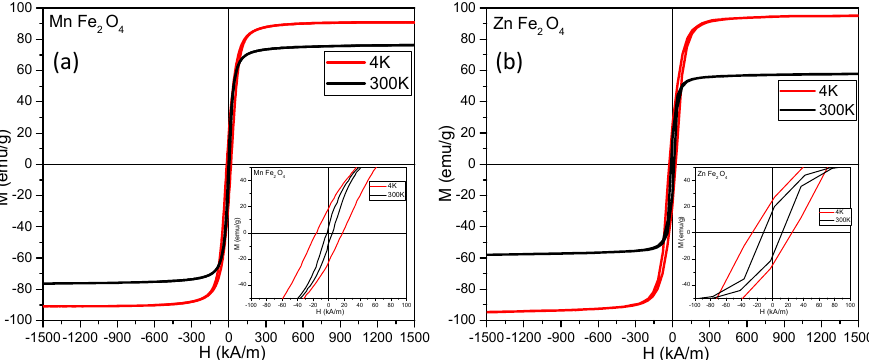
Figure 2. Magnetization curves ( M = f ( H )) for ( a ) MnFe 2 O 4 MNPs and ( b ) ZnFe 2 O 4 MNPs measured at 4 K and 300 K. Insets represent low-field regime hysteresis loops. Table 1. Magnetic properties of MnFe 2 O 4 and ZnFe 2 O 4 compared to Fe 3 O 4 (synthesized in EG).